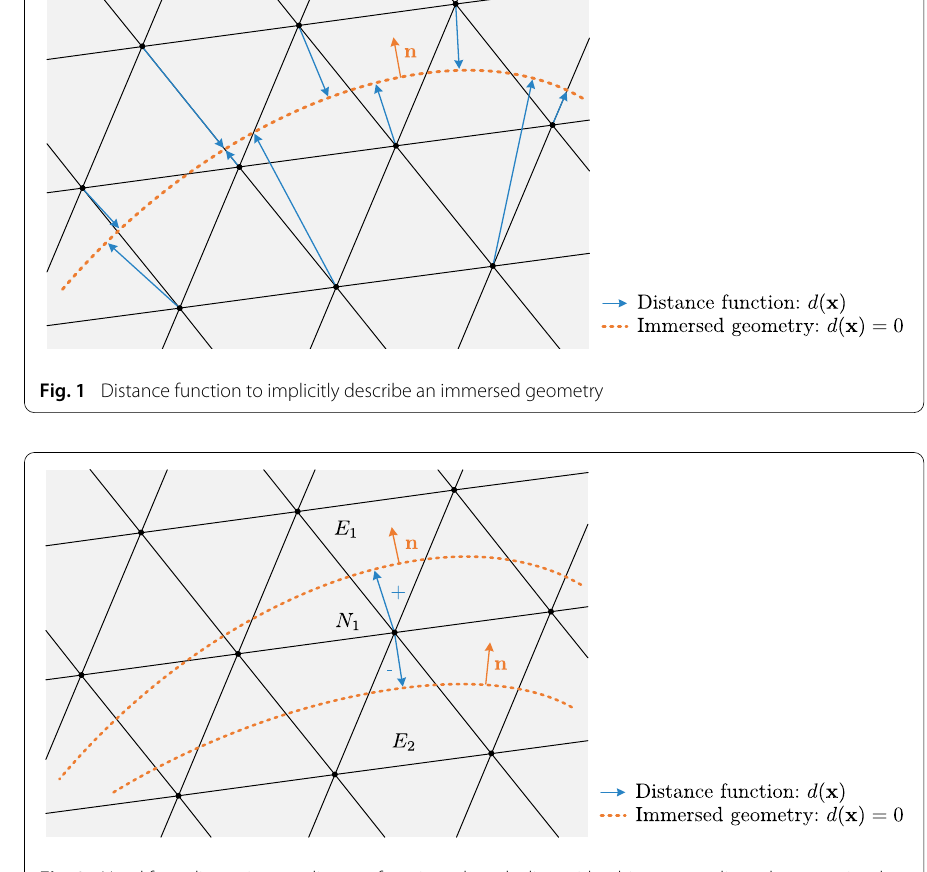
Fig. 2 Need for a discontinuous distance function when dealing with arbitrary complicated geometries due to a potential non-unique definition of signed